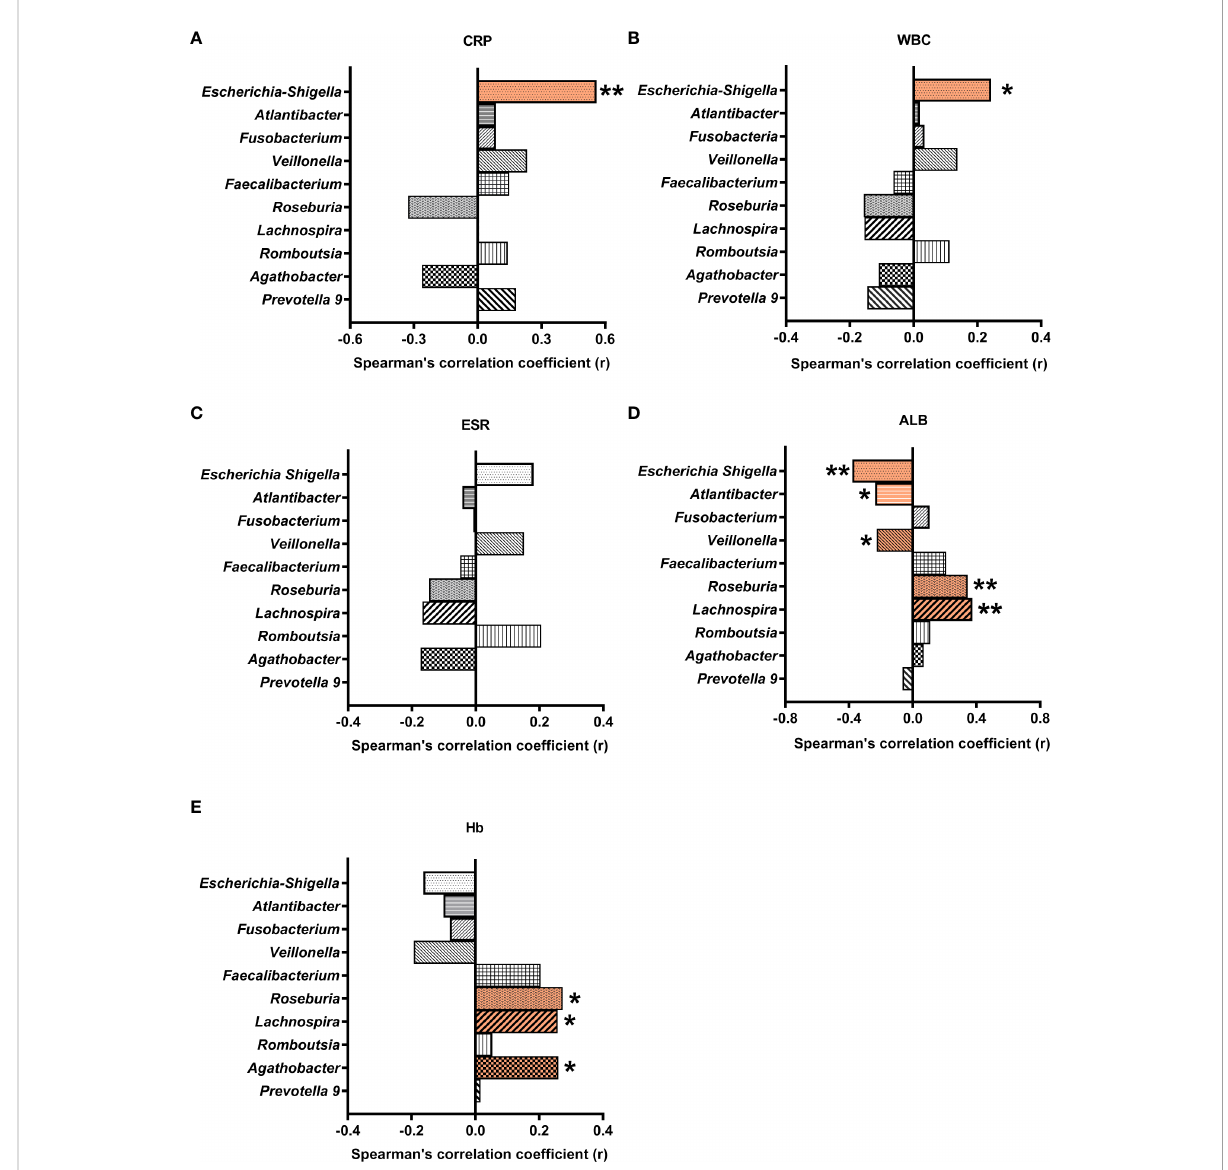
FIGURE 5 Correlations between differential gut microbial genera and blood biochemical indices. Multiple Spearman ’ s correlation analyses were conducted with CD and control samples. Correlation coef fi cients (r) were plotted for microbial genera correlated with CRP (A) , WBC (B) , ESR (C) , ALB (D) , and Hb (E) . * and ** indicate signi fi cant difference at a P value of < 0.05 and < 0.01, respectively. CRP, C-reactive protein; WBC, white blood cell count; ESR, erythrocyte sedimentation rate; ALB, albumin; Hb,